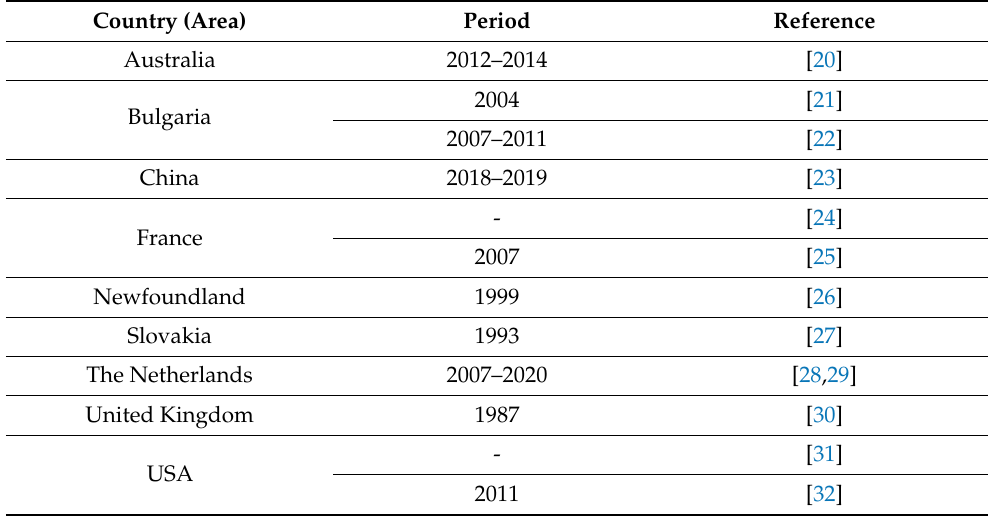
Table 1. Human Q fever outbreaks associated with goats. Country (Area) Period